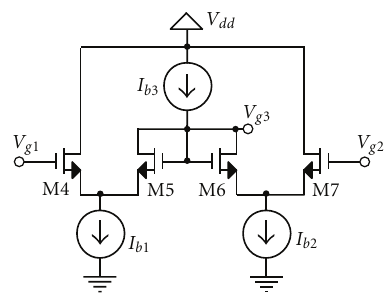
Figure 2: Basic circuit diagram of electronically simulated translin- ear loop. Figure 3: Circuit diagram of the voltage mean